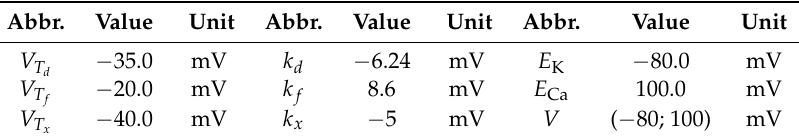
Table 1. System parameters of model